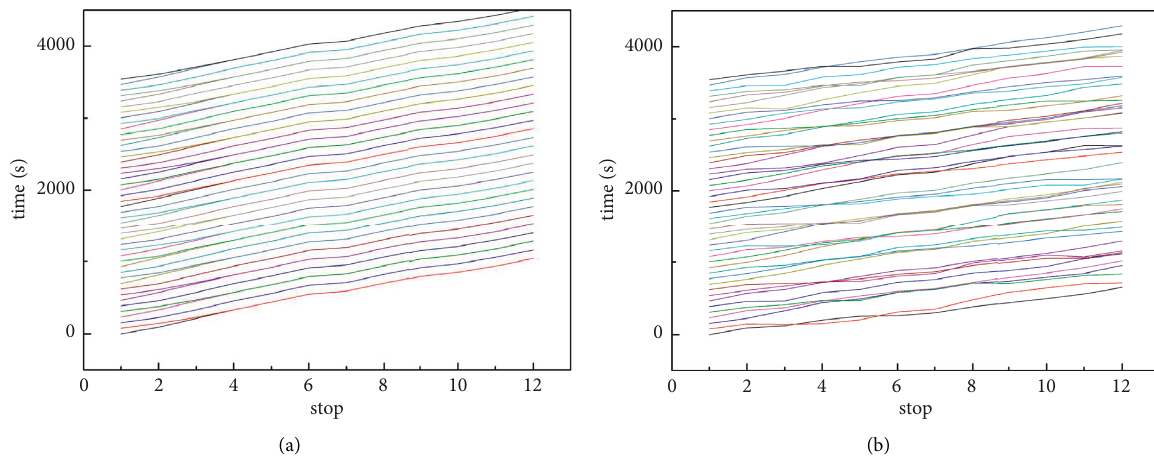
Figure 6: Vehicle trajectories in the overlapping segment (before and after optimization). (a) Vehicle trajectories before optimization. (b) Vehicle trajectories after optimization.